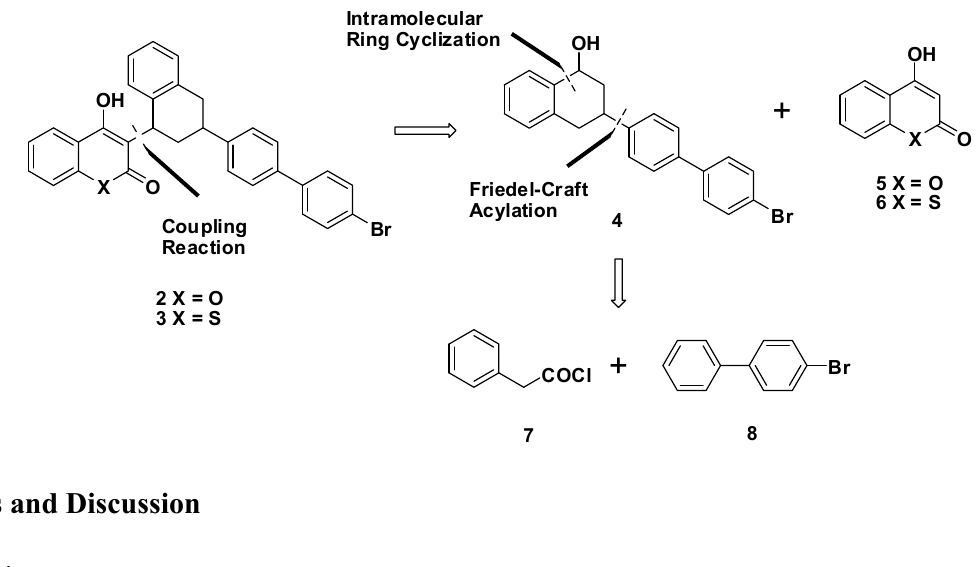
Intramolecular Ring